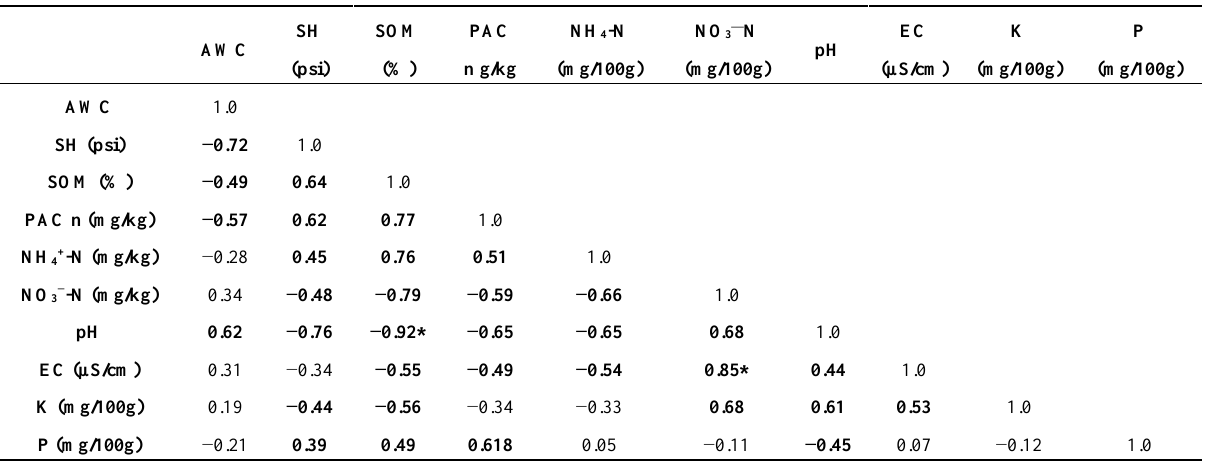
Table 4. Pearson correlation coefficients for the measured soil quality properties in the Schäfertal site, Germany. Bold numbers indicate significant differences with p ≤ 0.05 and bold numbers with (*) indicate highly significant differences with R ≥ 0.8 and p ≤